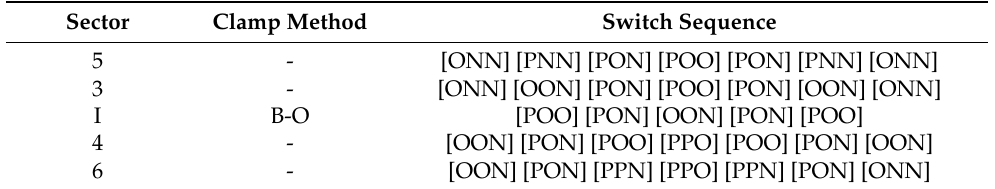
Table 2. Modulation method, clamping method, and corresponding switching sequence of different